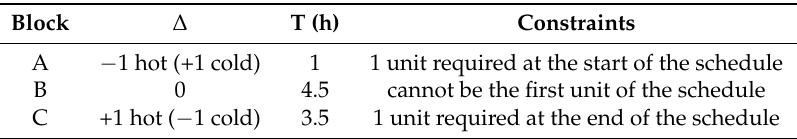
Table 2. Component details for BR-FEHE system with indirect integration.